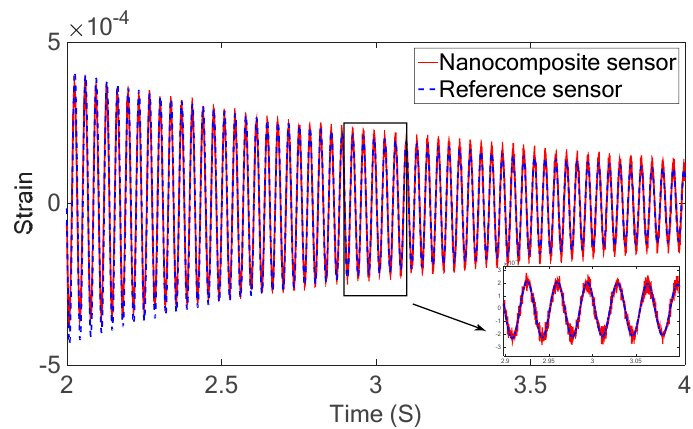
Figure 18. Free vibration response of the piezoelectric nanocomposite sensor and the metal foil strain gauge as reference sensor.